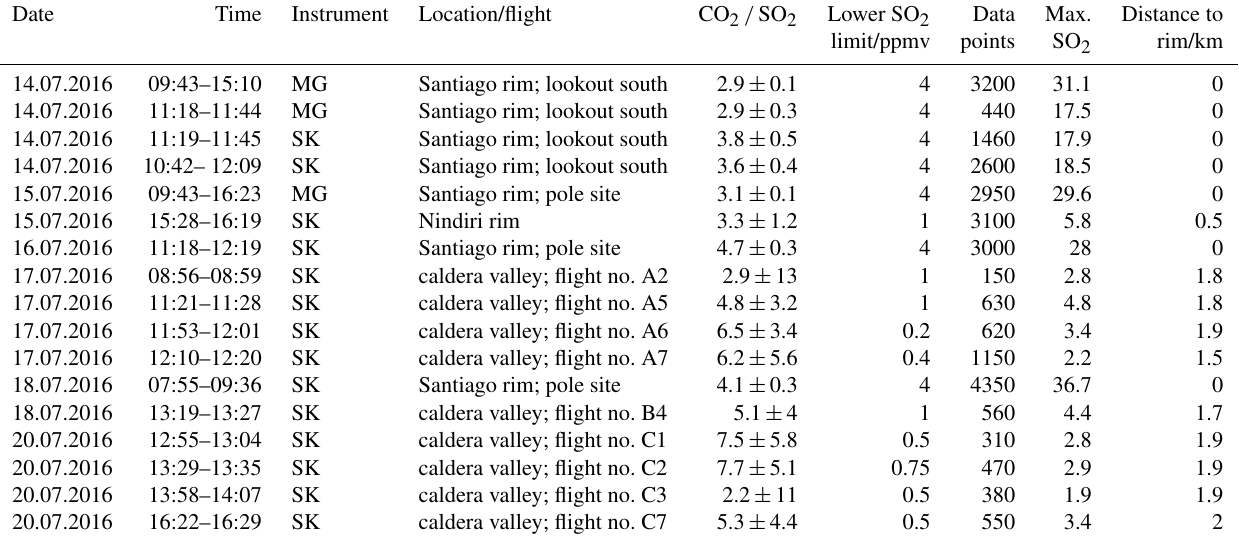
Table 3. CO 2 / SO 2 mixing ratios and calculation parameters obtained from the Sunkist (SK) and Multi-GAS (MG) instruments at Masaya volcano. The exact locations are given in Fig. 2; errors indicate 2 σ interval (95.5%) retrieved by a linear regression (York et al., 2004) including the measurement errors of both the SO 2 (error: 5–10%) and CO 2 (error: 5.5%)